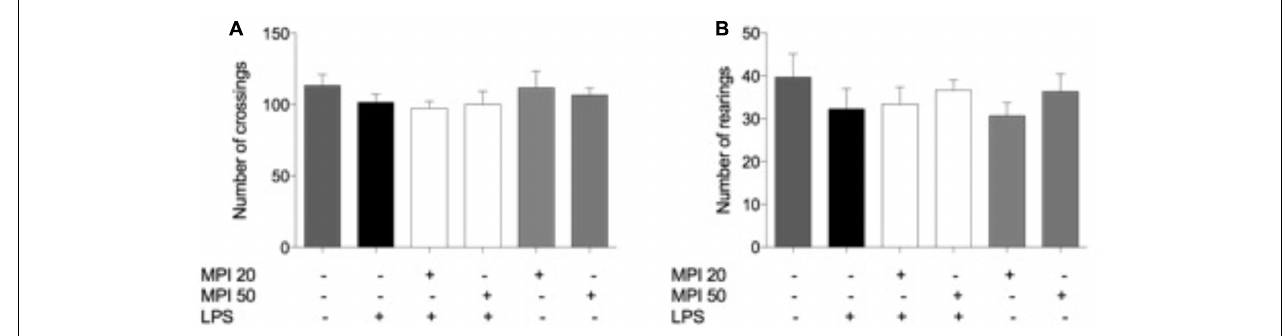
FIGURE 2 | Effects of MPI on the OFT induced by LPS. (A) Number of crossings and (B) rearings in OFT. Data are shown as mean ± SEM. ### p < 0.001 when compared to the control group. ∗∗∗ p < 0.001 when compared to LPS-induced group ( n = 6 for each group).